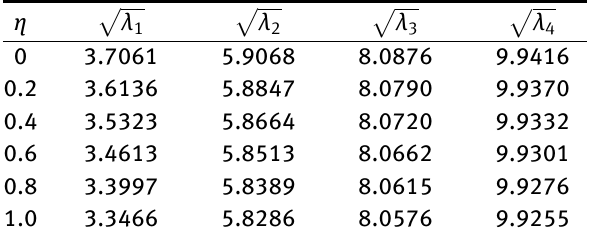
(︁ √ )︁ for CC case for different non- λ